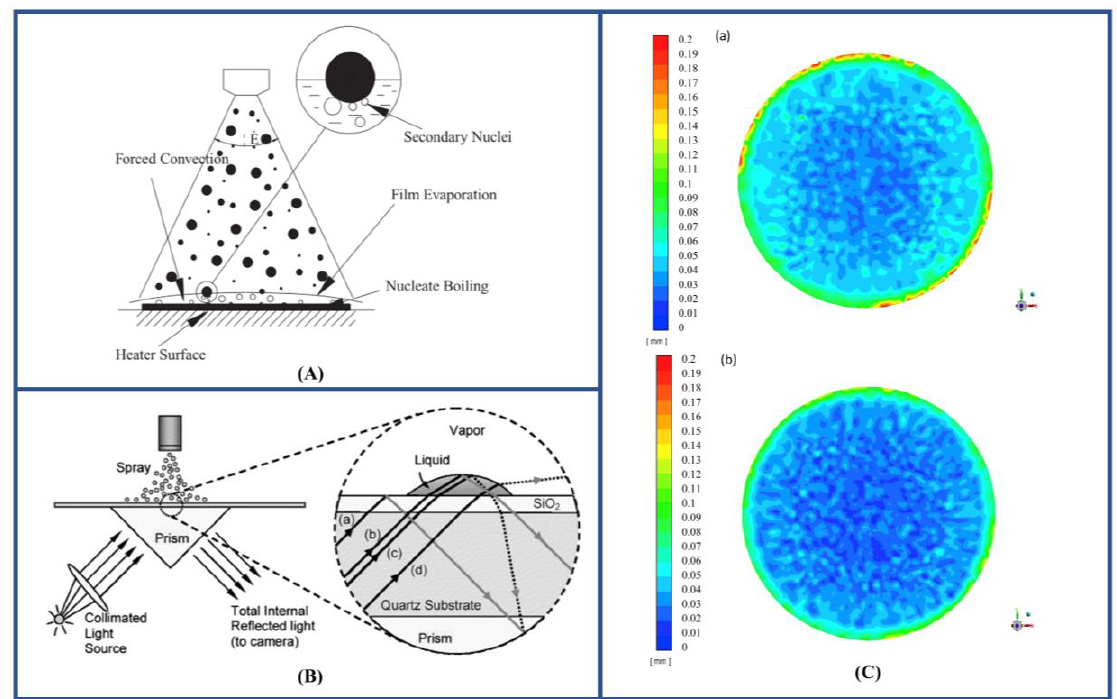
Figure 1. ( A ): Heat transfer mechanism in nucleate boiling regions [29]. ( B ): Using a total internal reflection technique to visualize and measure the liquid–solid contact area and the three-phase contact line length [26]. ( a ) undergoes a total internal reflection, while light incident on the SiO 2 /liquid interface is transmitted ( b – d ). Most of the light (96%) striking the liquid/vapor interface is transmitted into the liquid and subsequently is scattered by a combination of reflection at a sloped interface ( c ) or refraction into the vapor ( d ). Places where the liquid surface is completely parallel to the SiO 2 surface will reflect the light to the camera, but these are typically confined to regions smaller than the image resolution. ( C ): The thickness distribution of wall film with q = 50 W/cm 2 ( a ); q = 170 W/cm 2 ( b ) [27].